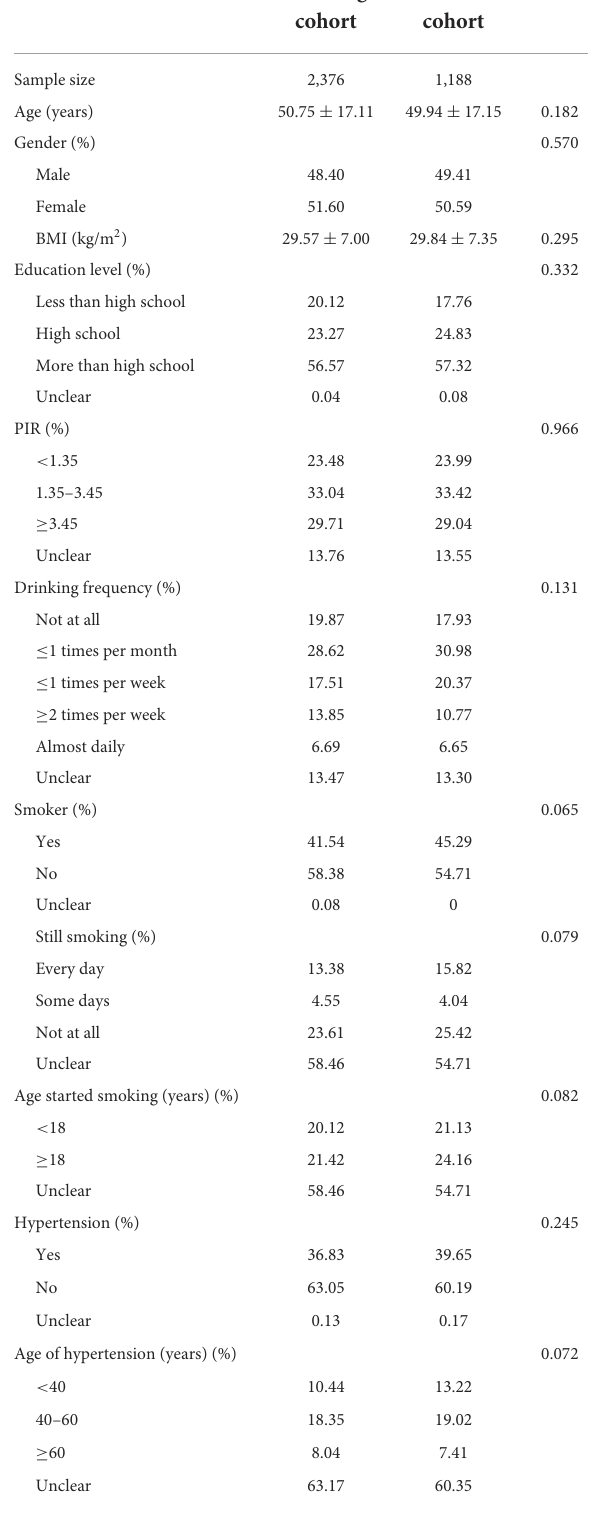
TABLE 1 Comparison of participant characteristics in the training and validation cohorts.